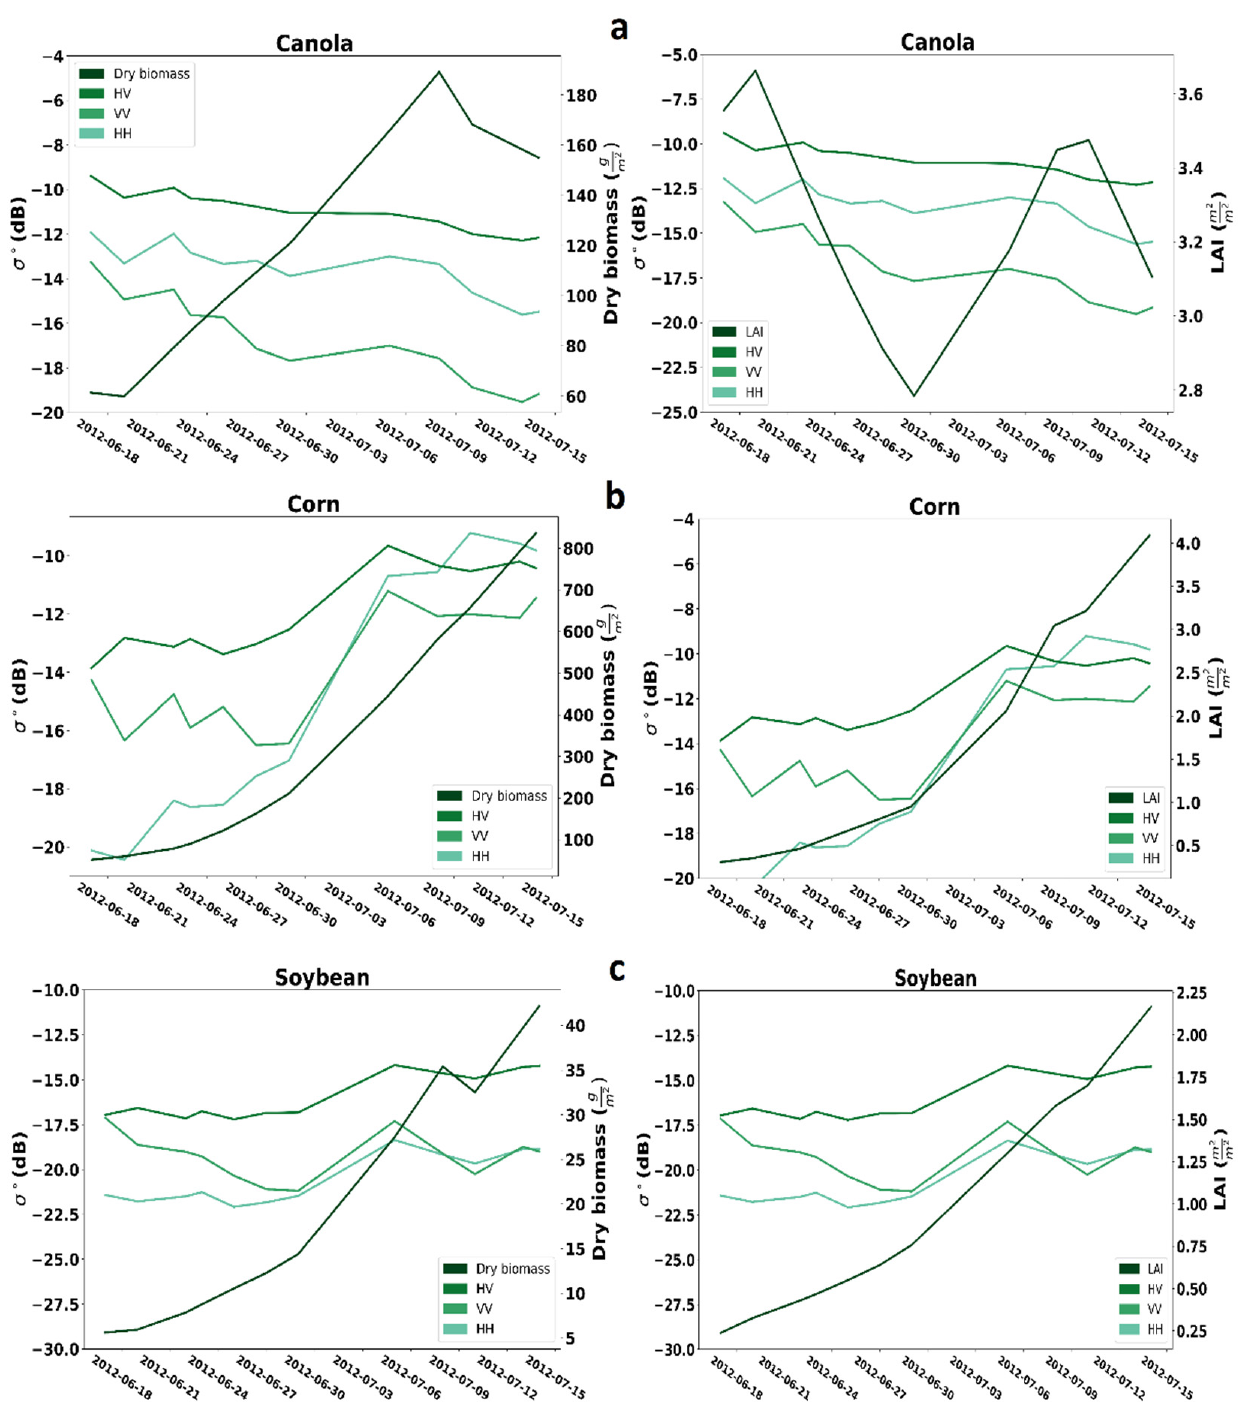
Figure 2. Temporal profile analysis for SAR backscatter coefficient of dry biomass and LAI for ( a ) canola, ( b ) corn, ( c ) soybean.